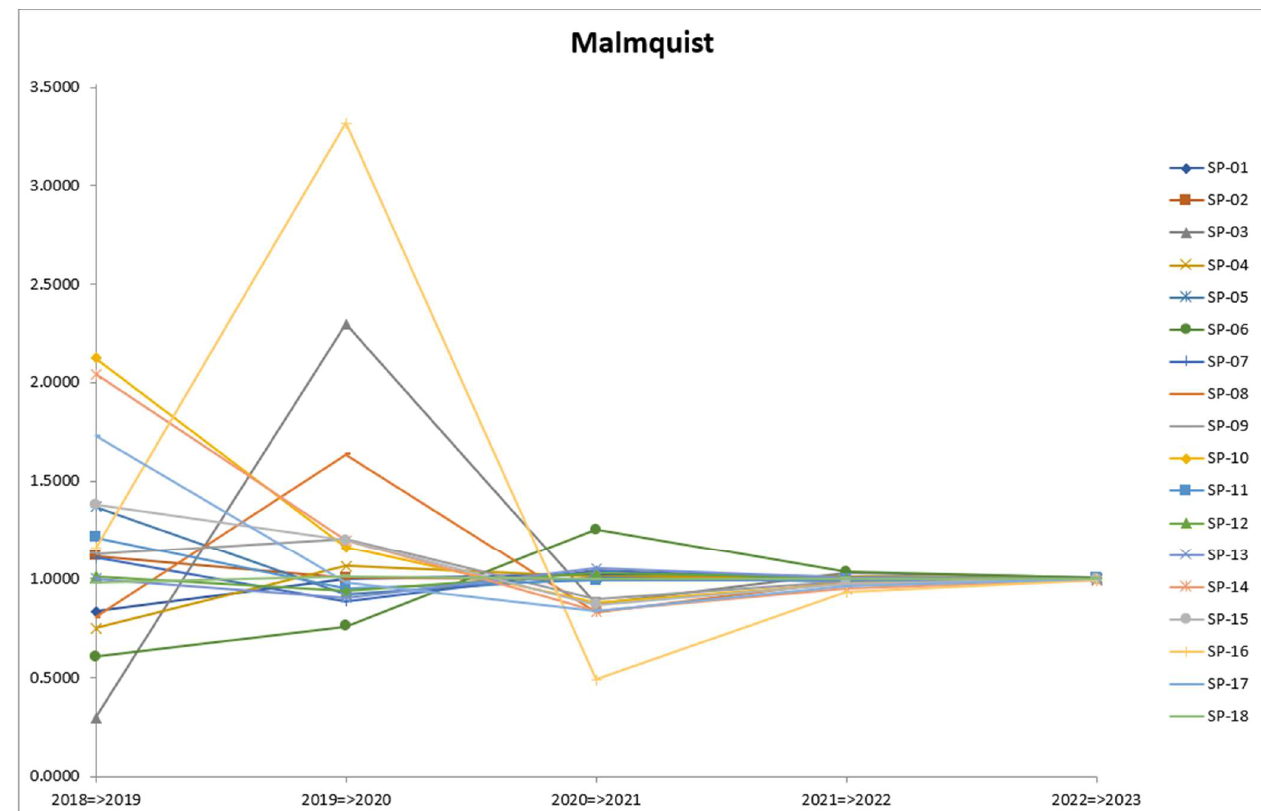
Figure 4. Total productivity change (Malmquist).